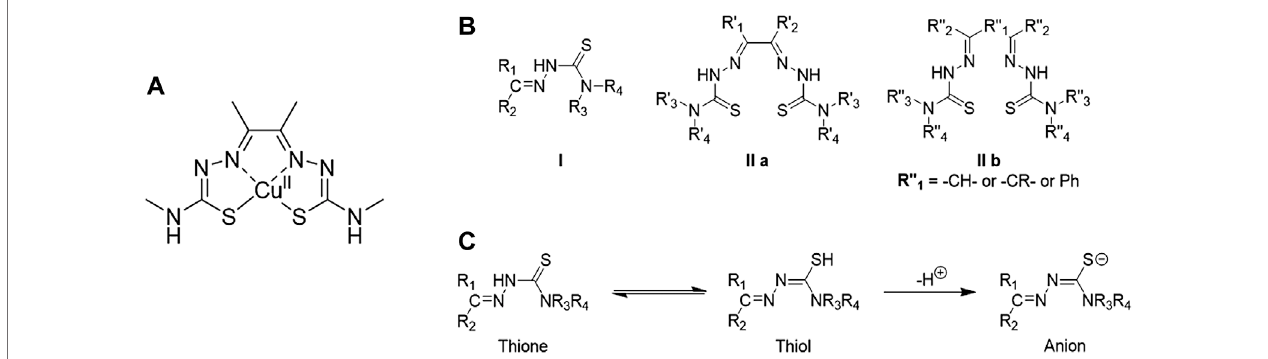
FIGURE 8 | (A) Structure of diacetyl bis(N4-methylthiosemicarbazonato) copper (II), well known as [Cu(ATSM)], (B) Structural representation of common TSC backbones: mono-TSC (I), non-bridged bis -TSC (IIa) and bridged TSC (IIb), (C) Thione-thiol equilibrium of TSC which can lead to the anionic form.